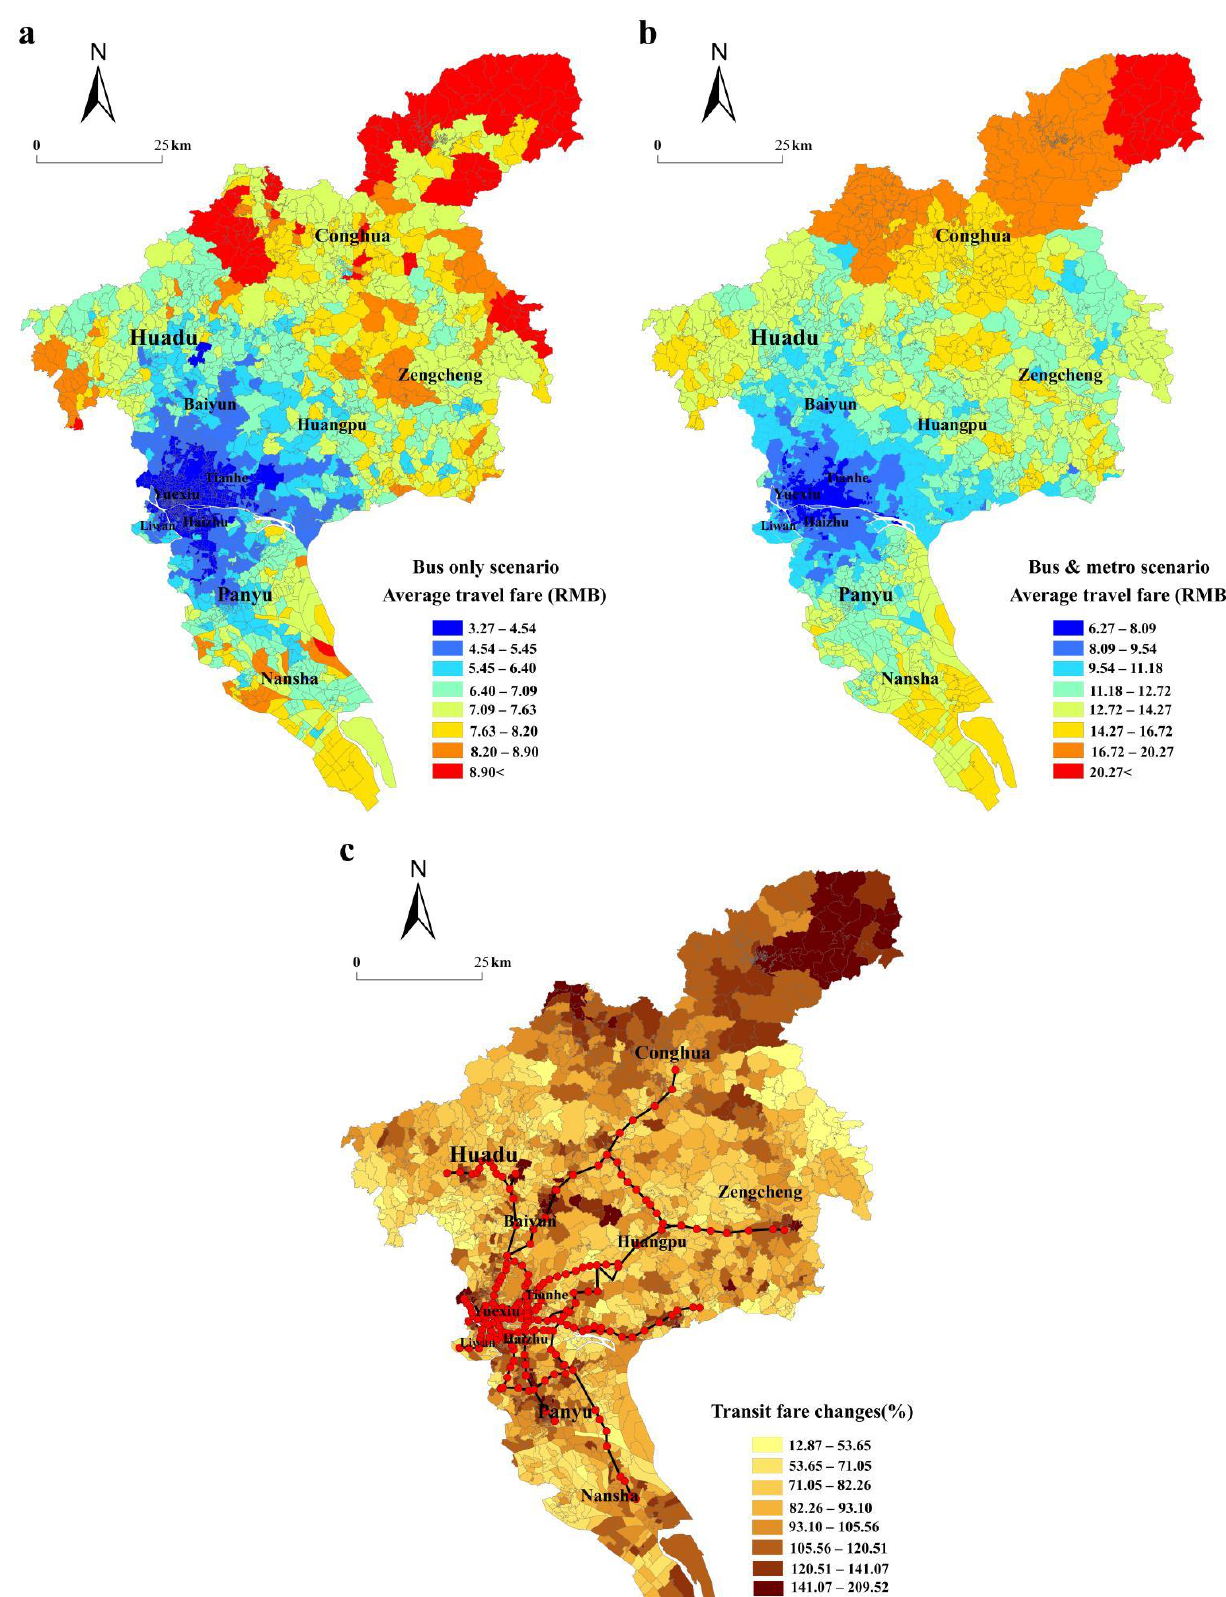
Figure 5. The spatial distribution of the transit fare of communities in the bus-only scenario ( a ), in the bus and rail transit scenario ( b ), and the fare changes between the two scenarios ( c ).